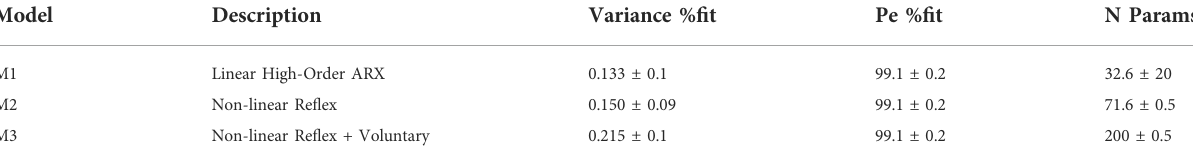
TABLE 1 Model statistics.